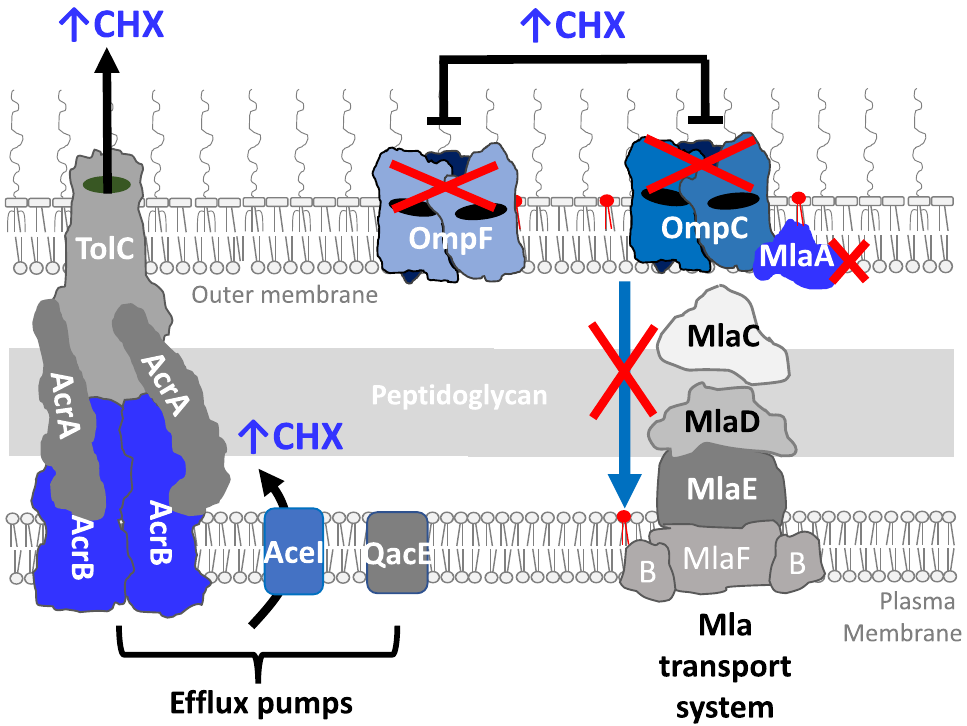
Figure 4. A diagrammatic summary of CHX resistance mechanisms compared in this study from the perspective of the E. coli cell envelope. Efflux pump systems, porins and MlaA as part of the intermembrane complex is shown. Complexes highlighted in blue show genes deleted (red X) or overexpressed in this study and their consequences for CHX